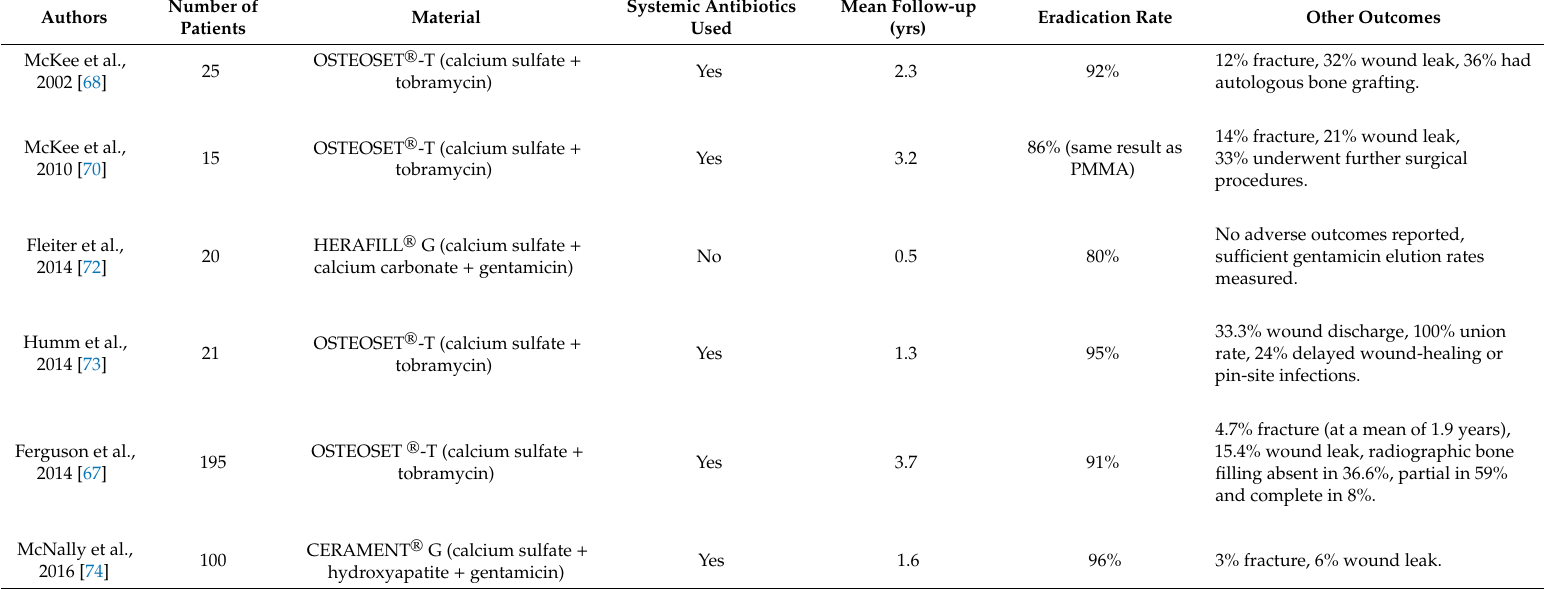
Table 1. Clinical studies focusing on antibiotic-eluting, resorbable, calcium-based sca ff olds for chronic